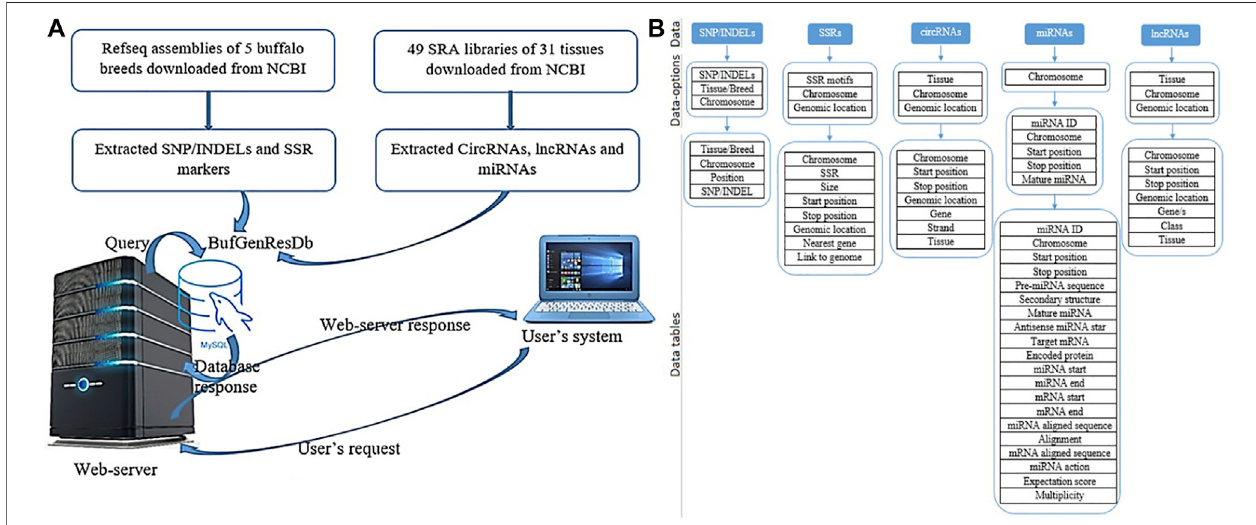
FIGURE 1 | (A) Database preparation and data retrieval for BuffGR ; (B) Layout of data, data options, and data tables of BuffGR .